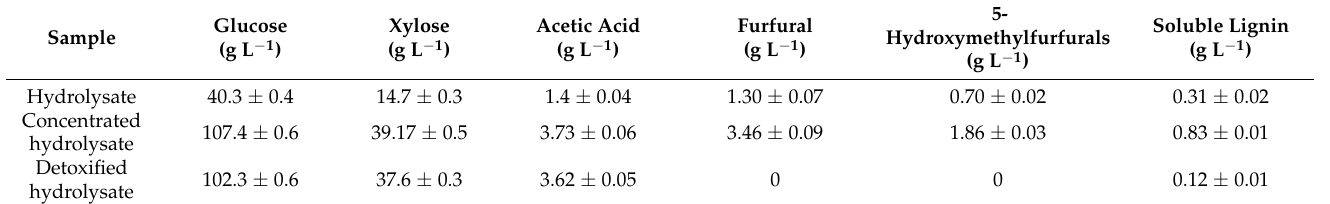
Table 2. Concentrations of fermentable fractions in lignocellulose hydrolysate.